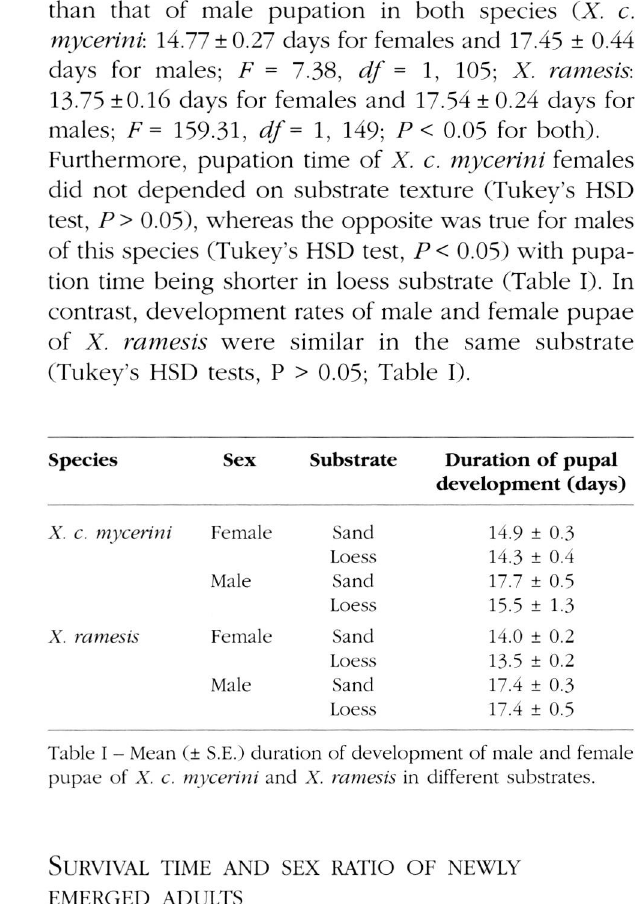
Table I - Mean (± S.E.) duration of development of male and female pupae of X. c. mycerini and X. ramesis in different substrates.